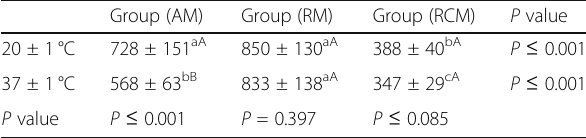
Table 1 The mean and standard deviation (SD) of the number of cycles to failure (NCF) for different groups